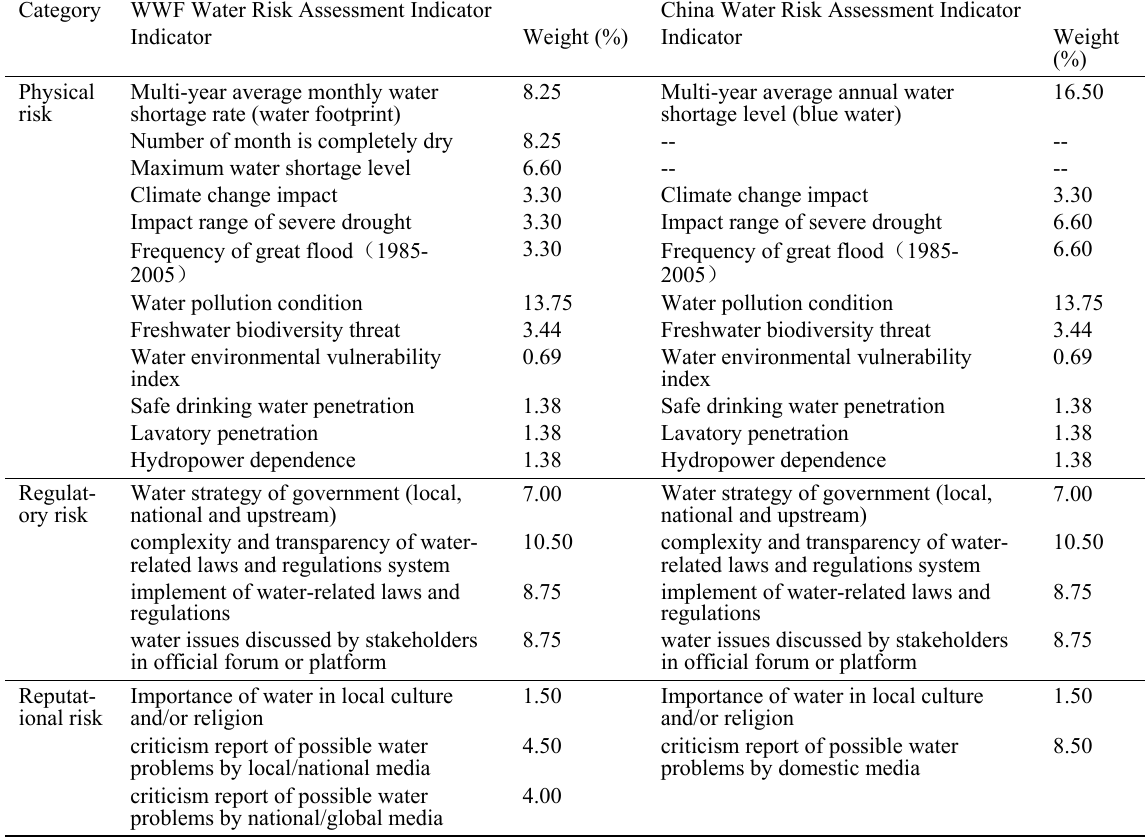
Table 1 Percentage weight of water risk assessment